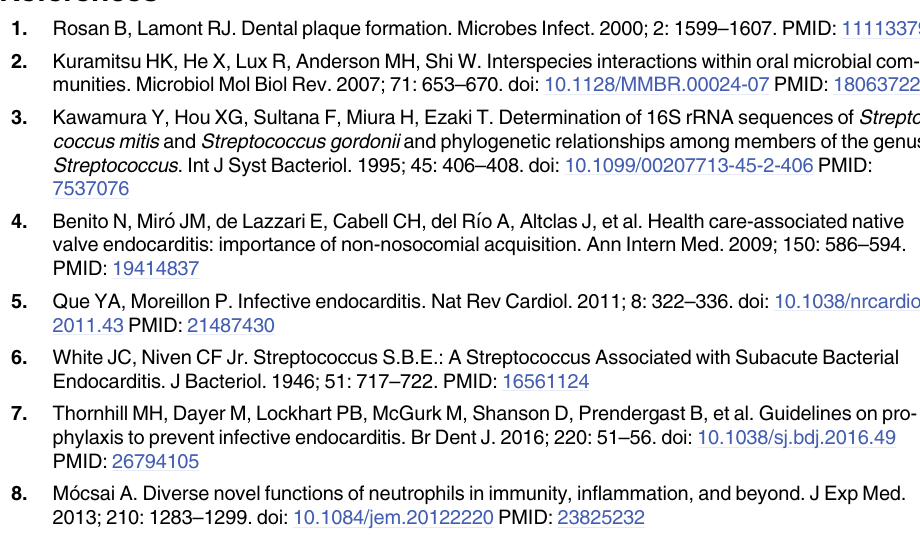
S1 Fig. Neutrophil cell death induced by S . sanguinis . Neutrophils were infected with the tested S . sanguinis strains at an MOI of 10. Exogenous addition of 1 mM of H PMA to neutrophils served as a control. Following incubation for 3 h and subsequent fixation, neutrophil elastase was labeled with a goat anti-human elastase polyclonal antibody and Alexa Fluor 594-conjugated anti-goat IgG. Nuclei were stained with DAPI. Bar, 20 μm.